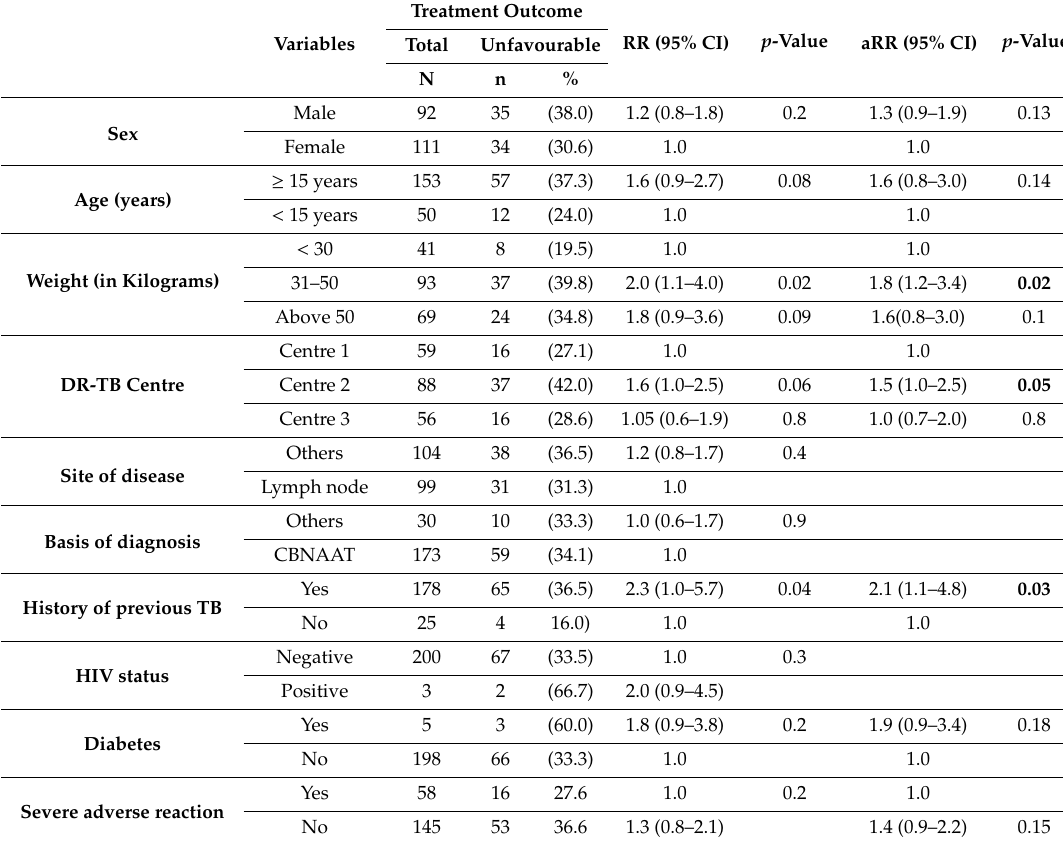
Table 4. Socio-demographic and clinical factors associated with unfavourable treatment outcomes among drug-resistant extrapulmonary TB cases in Delhi,